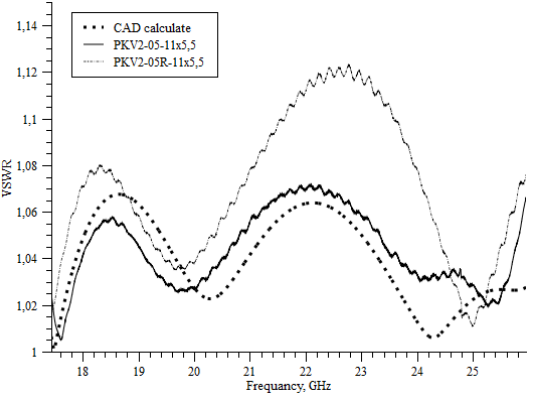
Fig. 4. Comparative graphs of VSWR measurement results of the prototypes and calculated value for the waveguide cross section of 7.2x3.4 mm.